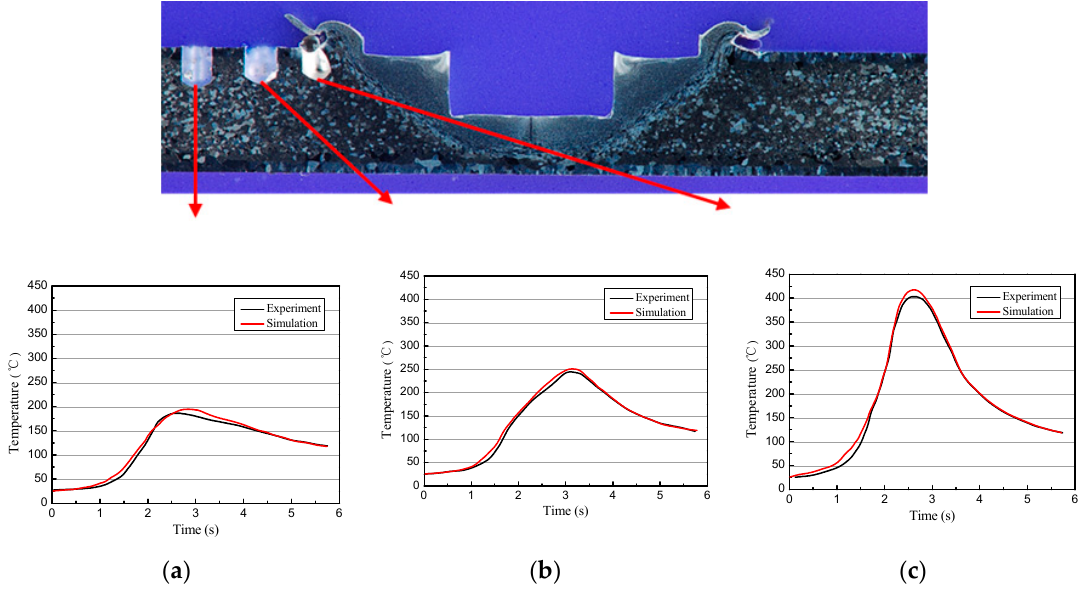
Figure 11. Temperature comparison between experiment and simulation using a tool rotating speed of 1600 rpm at the location of: ( a ) 5 mm away from outer edge of the shoulder; ( b ) 3 mm away from outer edge of the shoulder; ( c ) 1 mm away from outer edge of the shoulder.